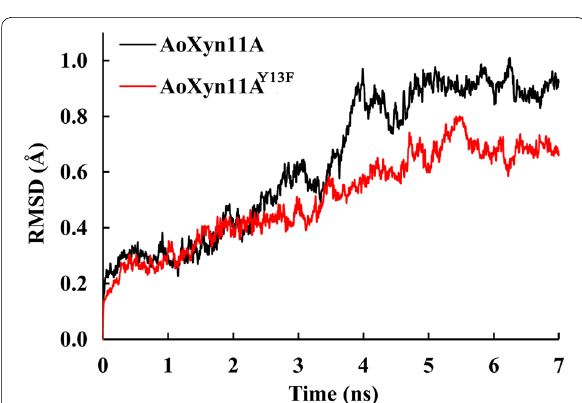
Fig. 3 The curves of RMSD values of AoXyn11A ( black line ) and AoXyn11A Y13F ( red line ). The modeled 3‑D structures of AoXyn11A and AoXyn11A Y13F were subjected to MD simulations, respectively, at 500 K for 7